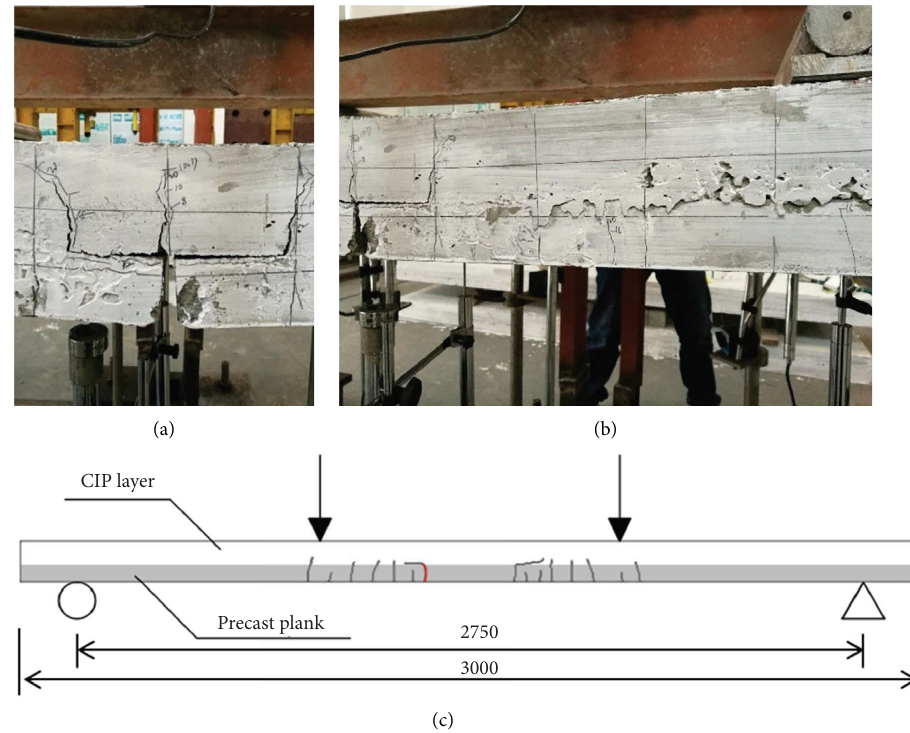
Figure 7: Failure phenomenon of LGSA1. (a) Cracking at midspan. (b) Cracking in the precast plank. (c) Crack pattern.